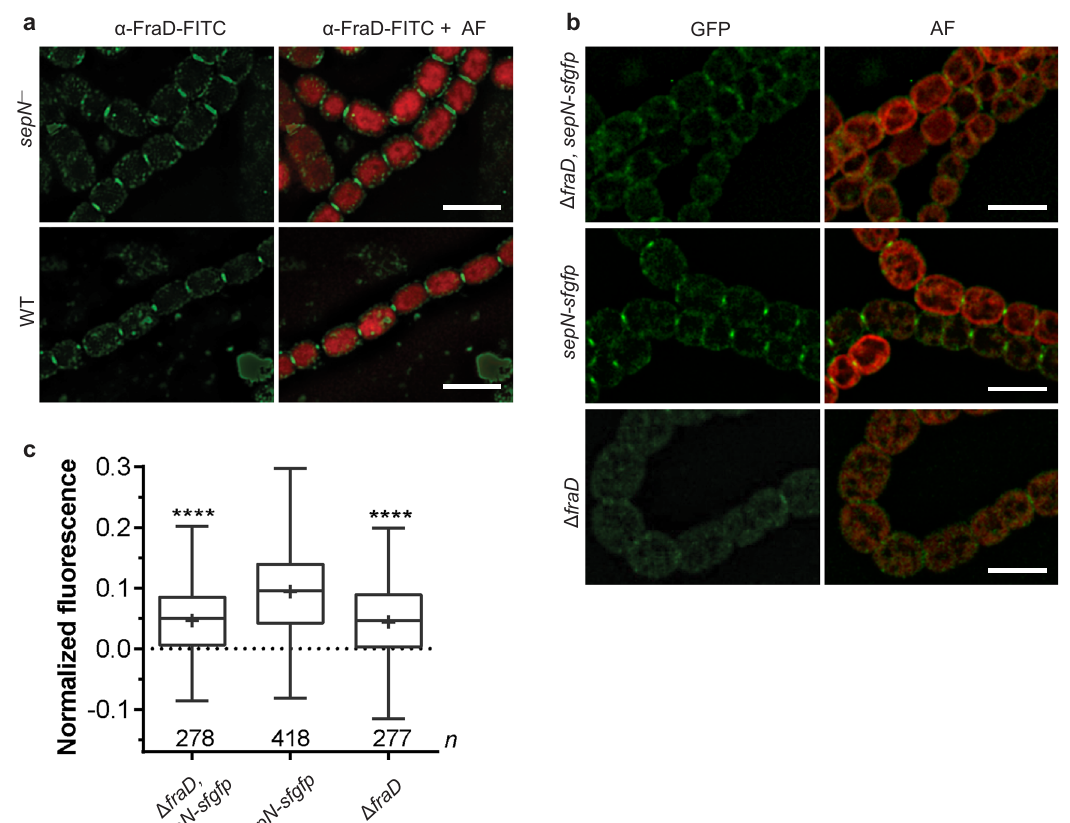
Fig. 2 | SepN requiresFraDfor septallocalization. a ImmunolocalizationofFraD in the sepN − mutant and in the WT revealed septal localization of FraD in both strains. The foci in the sepN − mutant, however, seemed to be less constricted compared to the WT. A primary α -FraD and FITC-coupled secondary antibodies were used for localizing FraD. Shown are representative 3D-deconvoluted fl uor- escenceimages.Bars,5 µ m.FITC, fl uoresceinisothiocyanate;AF,auto fl uorescence. b Fluorescence light microscopy images of SepN-sfGFPin the WT and in the Δ fraD mutantshowedseptallocalizationofSepNonlyintheWT.Thisindicatesthatseptal localization of SepN might be dependent on FraD. Plasmid pIM834 encoding for sepN-sfgfp was single recombinantly inserted into the genomic sepN gene of the Δ fraD mutant or WT background. Representative 3D-deconvoluted micrographs